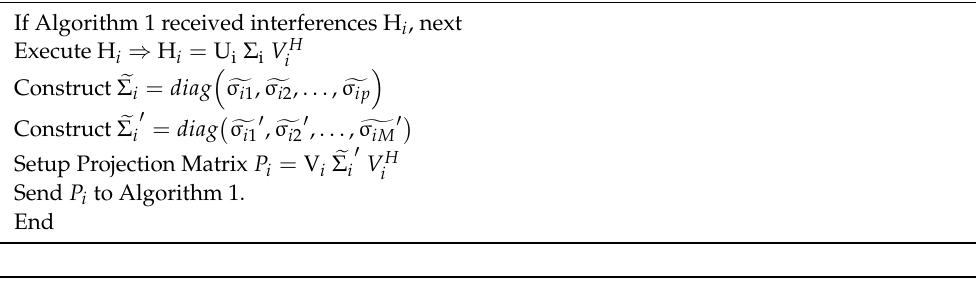
Algorithm 2 . Projection for Algorithm 2 on 1st Scenario.